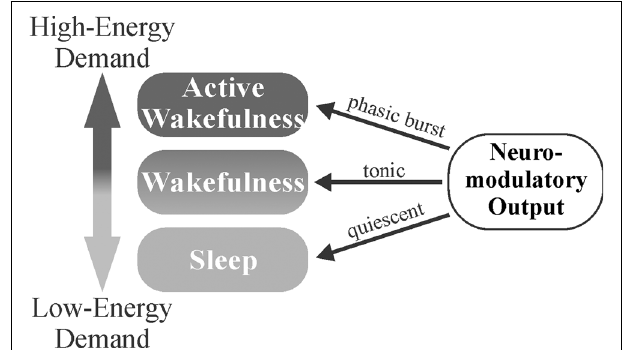
FIGURE 4 | Neuromodulator-mediated gating of brain activity states may serve a homeostatic role. The balance of tonic vs. phasic firing may allow for the appropriate matching of environmental demands to the degree of attention. Less-metabolically demanding wakefulness is maintained during tonic firing with more metabolically demanding, desynchronized activity states gated behind phasic neuromodulatory bursts that trigger in response to salient stimuli. Decreased neuromodulatory tone during sleep (synchronized activity states) allows for clearance of metabolites that have accumulated during